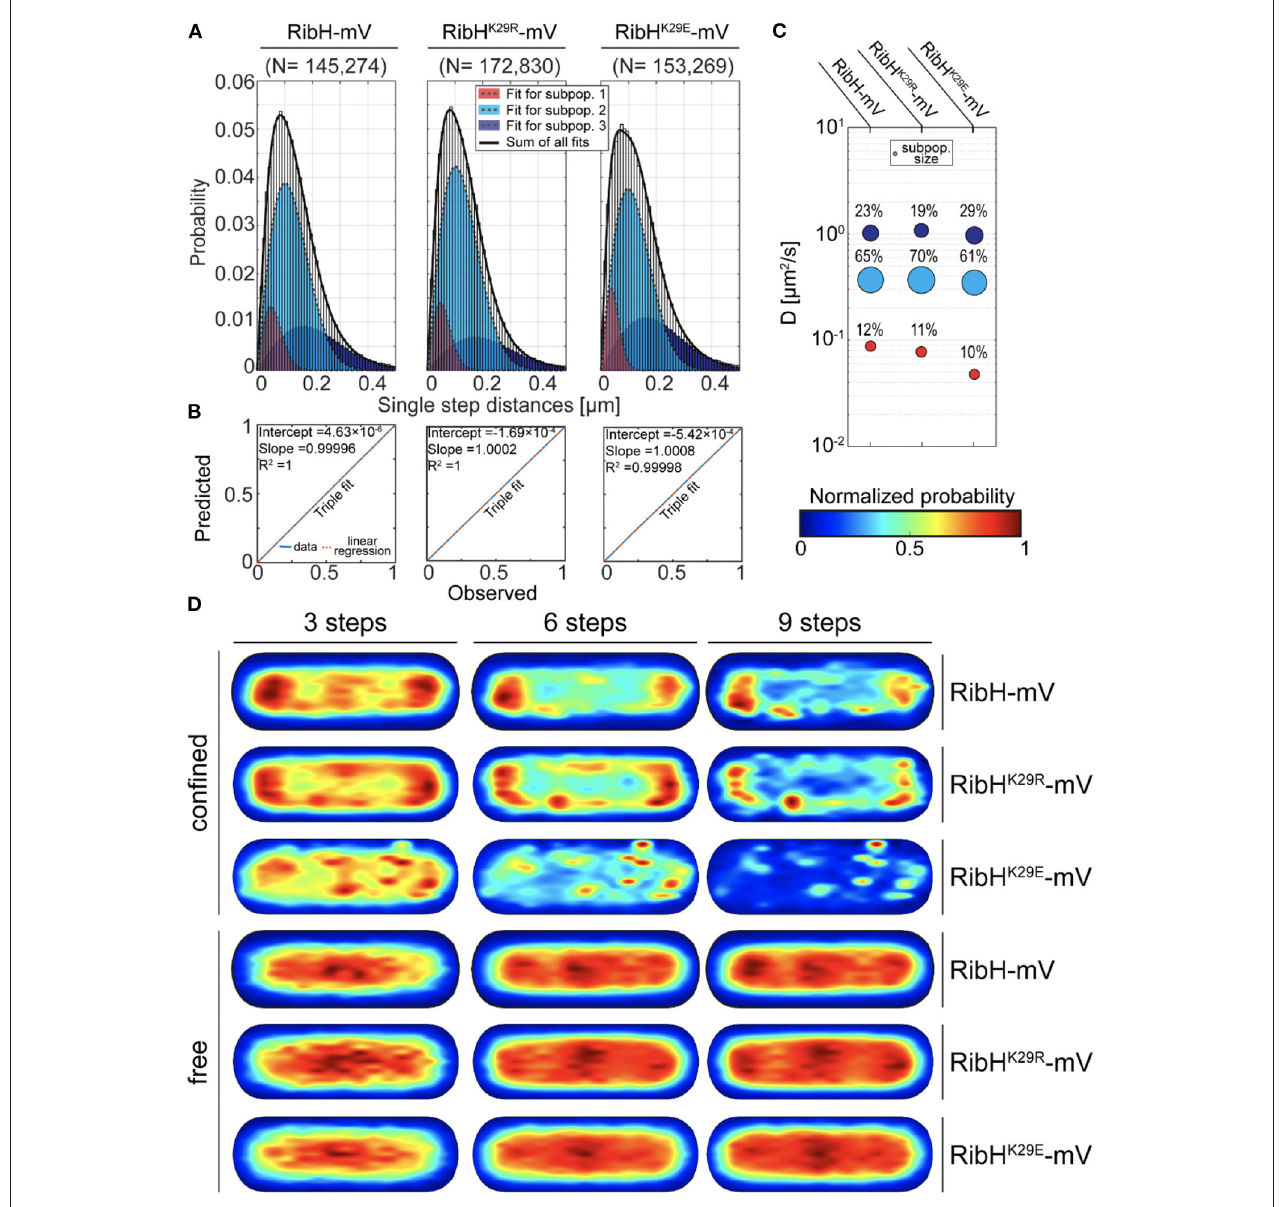
FIGURE 6 | The RibH K29R -mV mutant reveals SPT dynamics similar to RibH-mV in absence of ribT , whereas the RibH K29E -mV mutant shows a decrease in the subpopulation considered to contain capsids. (A) JD analysis of RibH-mV SPT data in comparison with SPT datasets from two mutant strains RibH K29R -mV and RibH K29E -mV using a three-component Rayleigh Mixture model. (B) Model prediction vs. observation plots for the Rayleigh Mixture models of JDs in (A) . (C) Bubble plots displaying relative proportions of subpopulations for RibH-mV and the two mutant strains and their according DCs that are derived from JD analysis in (A) . (D) Subcellular analysis of confined and free trajectories shown for different numbers of consecutive steps projected onto the cytoplasm of a normalized cell representation. Displayed are the results using the radii of confinement given in Table 3 with three, six, or nine consecutive steps of confinement.